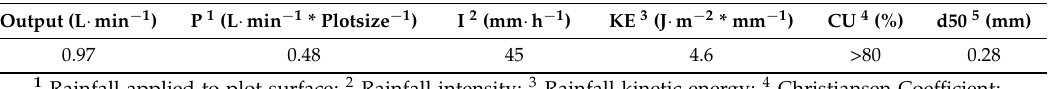
Table 2. Rainfall characteristics during simulation runs (operating pressure = 0.09